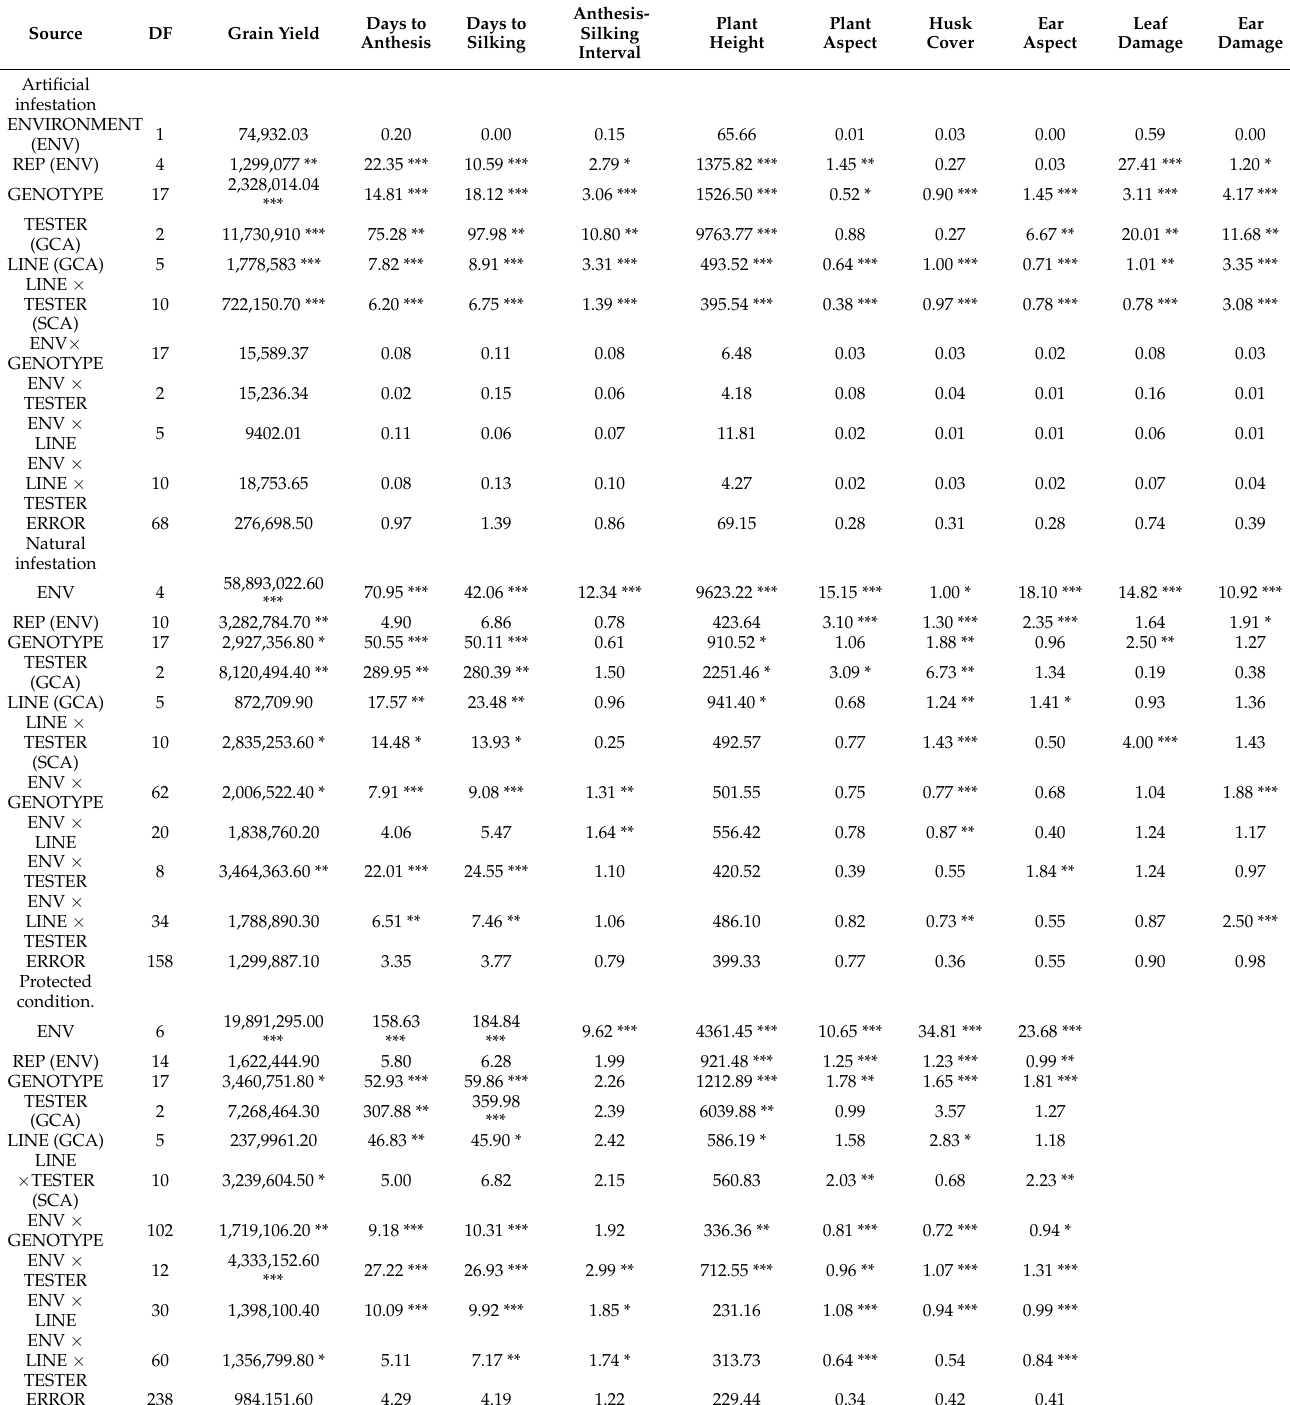
Table 2. Mean squares from the ANOVA for agronomic and fall armyworm resistance traits of maize test crosses evaluated under infested and protected